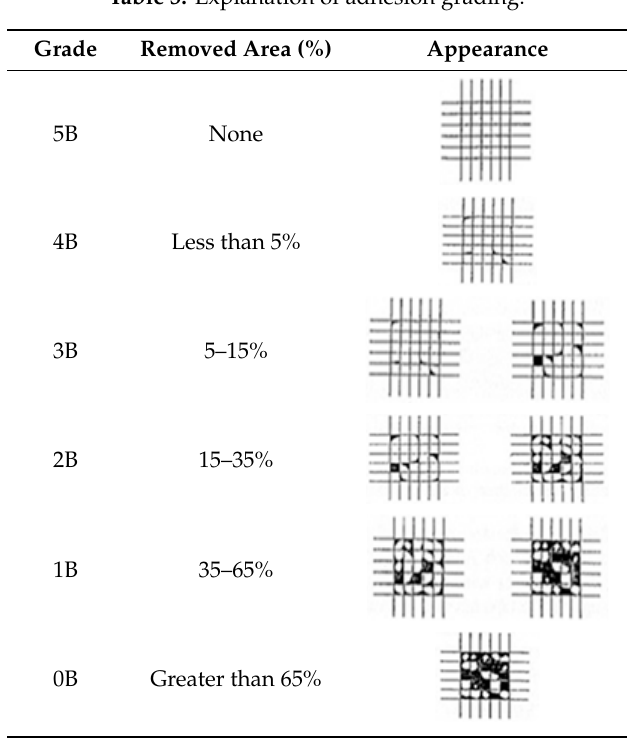
Table 3. Explanation of adhesion grading.